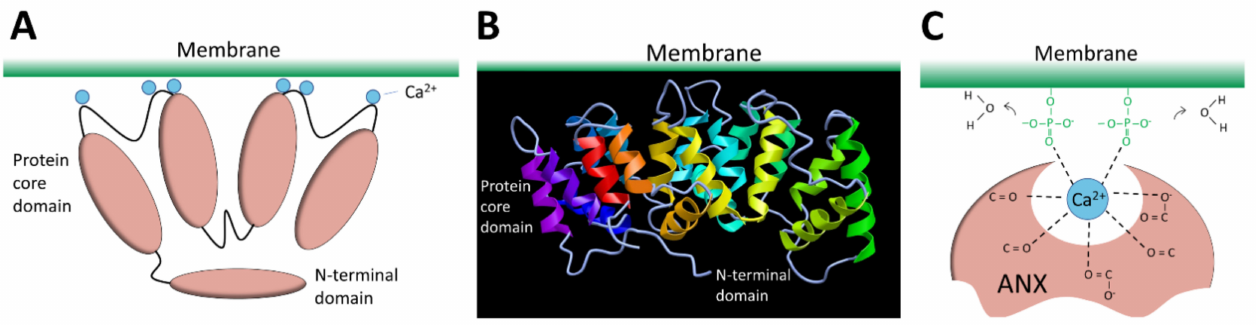
Figure 4. Structure of ANX. ( A ) Schematic representation of ANX. The four repeat sequences of the core domain fold into a curved-shape disk. The convex face binds Ca 2+ (blue spheres) and interacts with membrane. The N-terminal domain varies between ANX and regulates their function by interacting with other proteins. ( B ) Representation of the tertiary structure of ANX. Image of 1AVH (human ANXA5) [103] created with MMDB [104]. ( C ) Schematic representation of molecular interactions between ANX, Ca 2+ , and